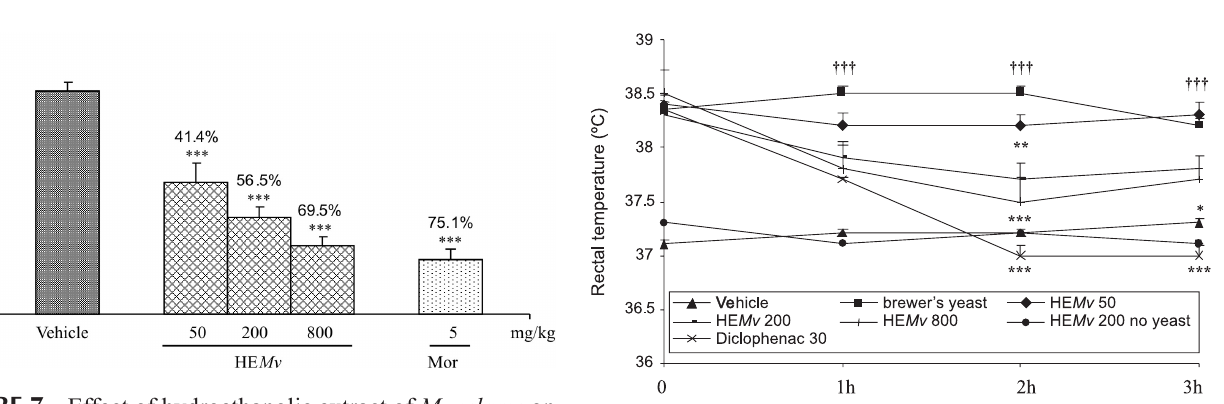
FIGURE 8 - Effect of hydroethanolic extract of M. velame on brewer’s yeast induced pyrexia in rats. Each value is the mean ± S.E.M. of 6-8 rats. *p<0.05, **p<0.01, ***p<0.001 compared with control or †††p<0.001 compared with yeast. One-way ANOVA followed by